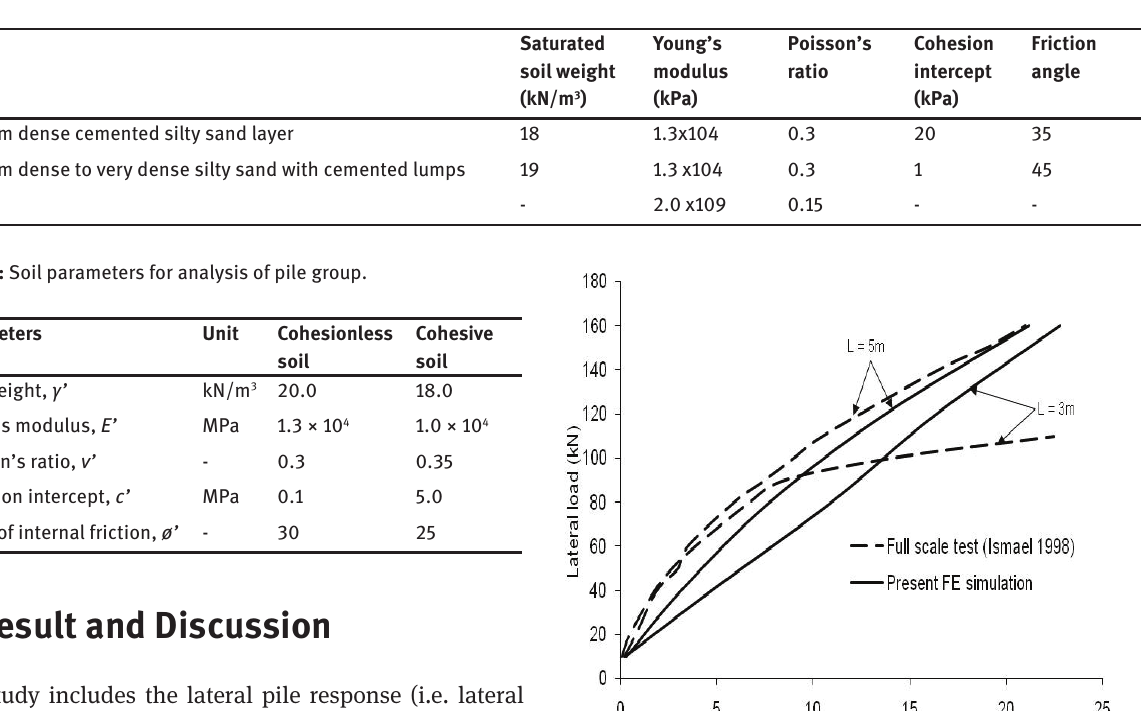
Table 1: Geotechnical properties of the soil layers.